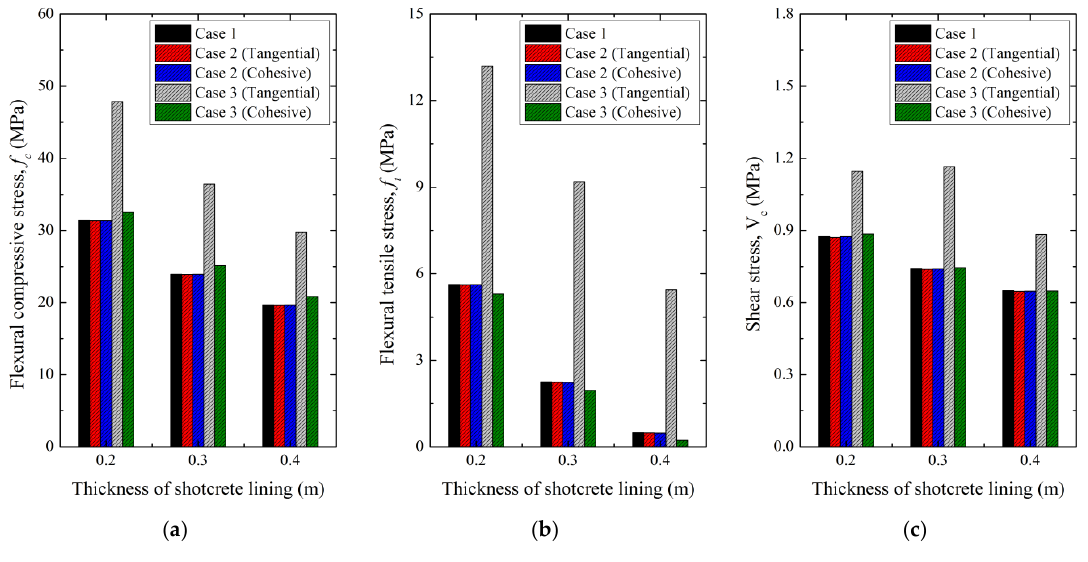
Figure 16. Result for each case for ( a ) flexural compressive stress, ( b ) flexural tensile stress, and ( c ) shear stress.